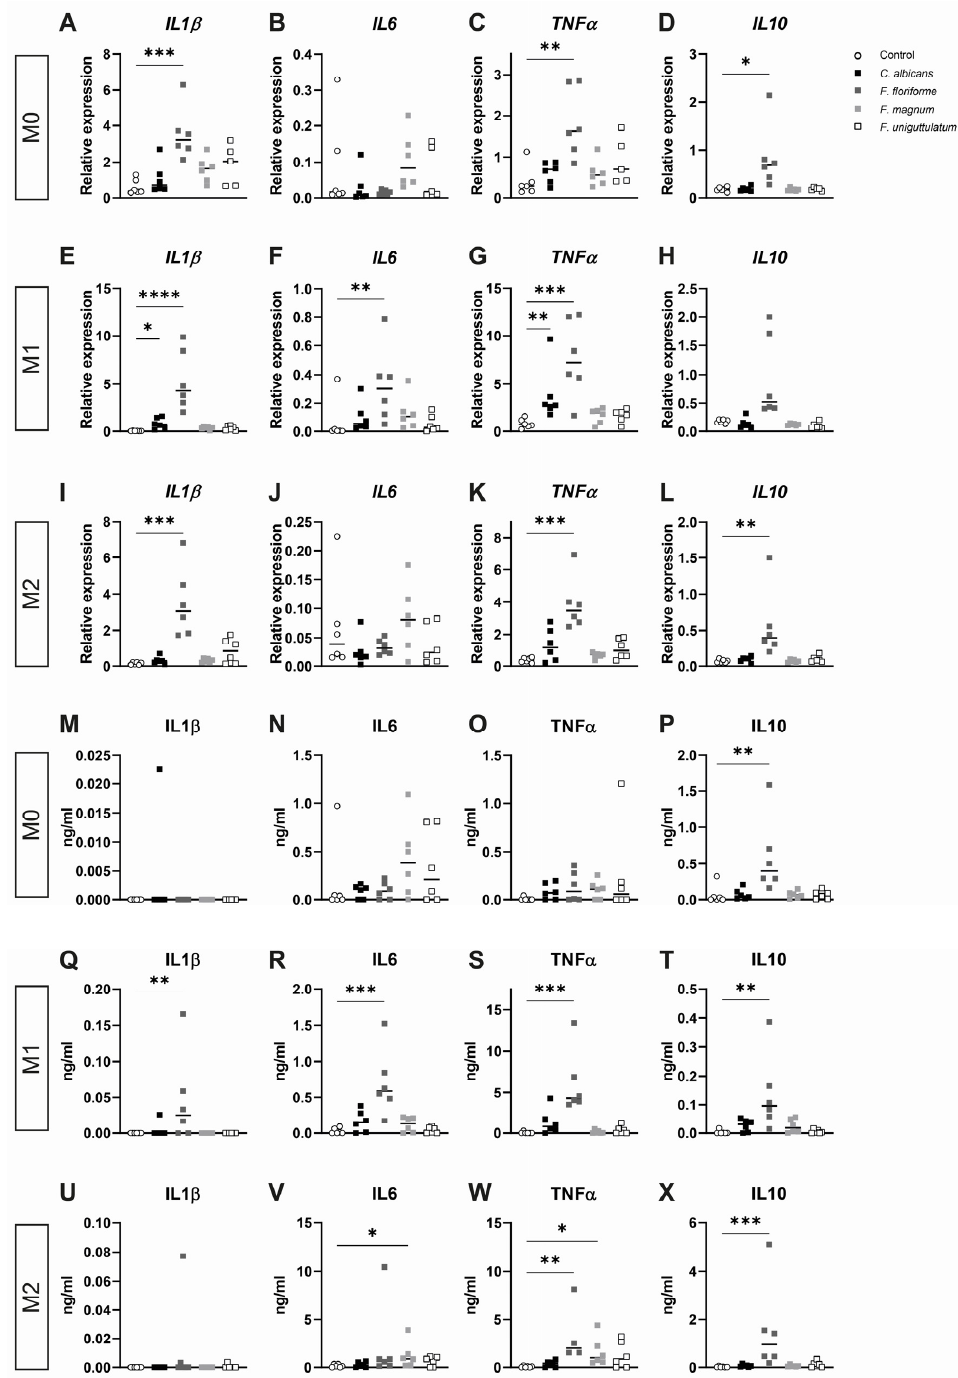
Figure 2. Stimulation of monocyte-derived macrophages to Filobasidium spp. results in cytokine response. ( A – L ) Relative expression levels of cytokines IL1 β , IL6, TNF α , and IL10 across M0, M1, and M2 polarized monocyte derived macrophages (( A – D ), ( E – H ), ( I – L ), respectively) after 4 h stimulation with yeast species ( n = 5–6 individuals). mRNA expressions are normalized against housekeeping genes, PPIA and PSMB6 . ( M – X ) Released cytokines (IL1 β , IL6, TNF α , IL10) by monocyte-derived macrophages skewed into M0, M1, or M2 phenotype (( M – P ), ( Q – T ), ( U – X ), respectively) and stimulated with yeasts for 24 h ( n = 4–6 individuals). Data represented as median and separate data points. * p < 0.05; ** p < 0.01; *** p < 0.005; **** p <